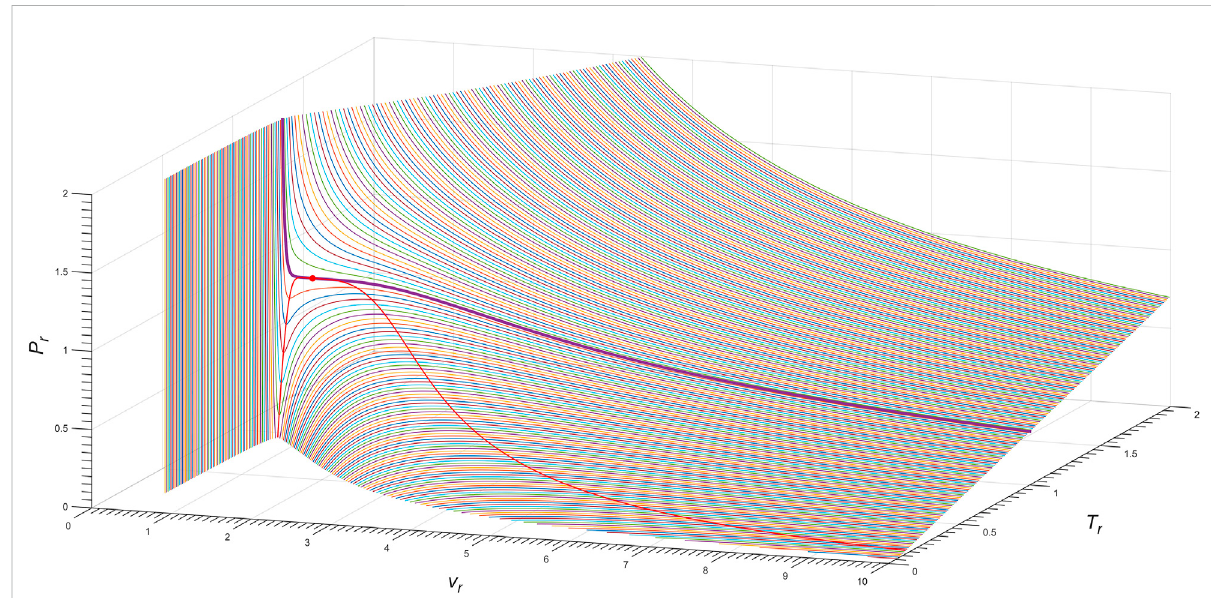
Three-dimensional P r − v r − T r phasediagramoftheexact n =4JanusvanderWaalsEq.7,asfornitrogen(N 2 ).Theboldpurplelinecorresponds totheisothermof T r =1.00,asdepictedinFigure9B;theredlineistheJanusvanderWaalsspinodalcurvewith a =0.99;andthereddotisthecritical point.